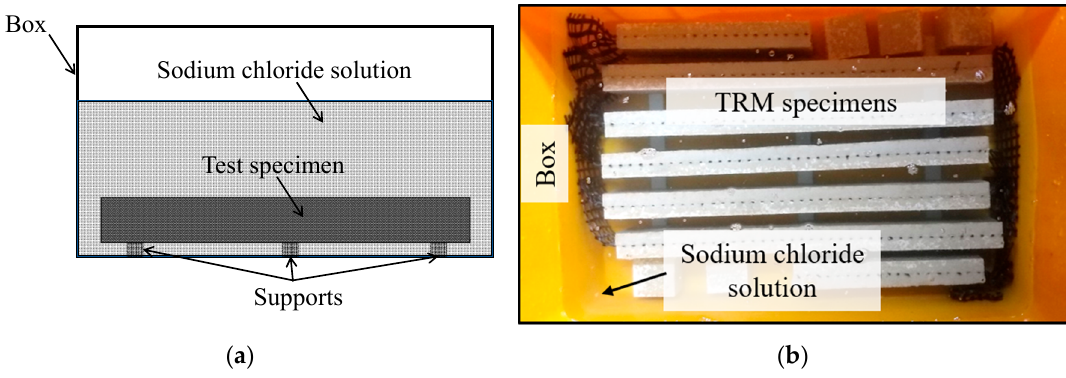
Figure 5. Test setup of TRM coupons subjected to the chloride environment: ( a ) scheme of the test setup of TRM coupons subjected to the chloride environment; ( b ) photo of test setup.